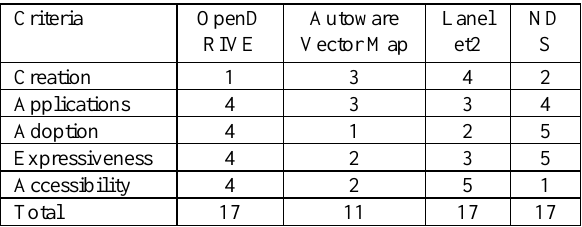
Table 1. Comparison within different aspects of each HD Map format (Edgar,